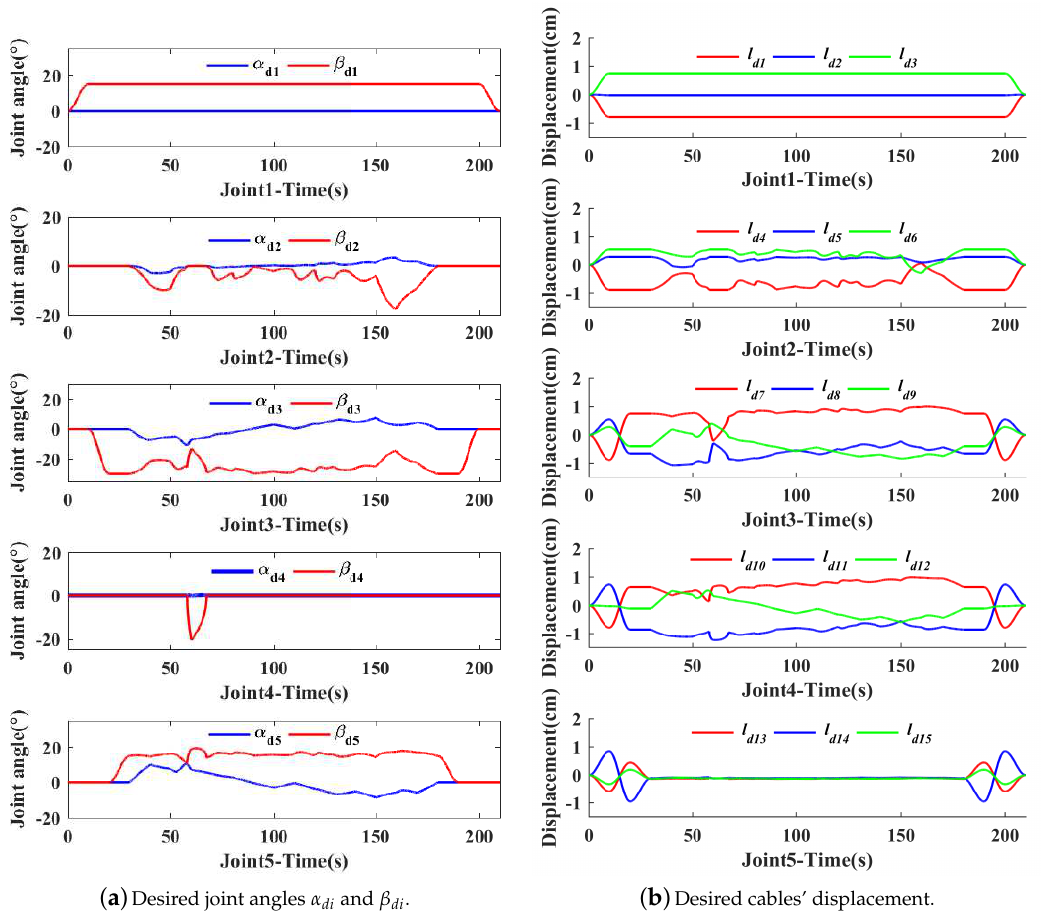
Figure 8. Desired joint angles and cables’ displacement of writing on a white board.